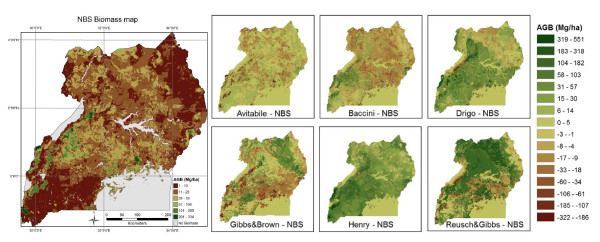
NBS reference biomass map (left) and difference of AGB values between the biomass maps and the NBS map (right). The difference maps, obtained by subtracting the corresponding map pixels, indicate overestimation with positive values (in green) and underestimation with negative values (in brown) in comparison to the NBS map. The NBS map is modified from [20]. AGB is reported in Mg ha-1.